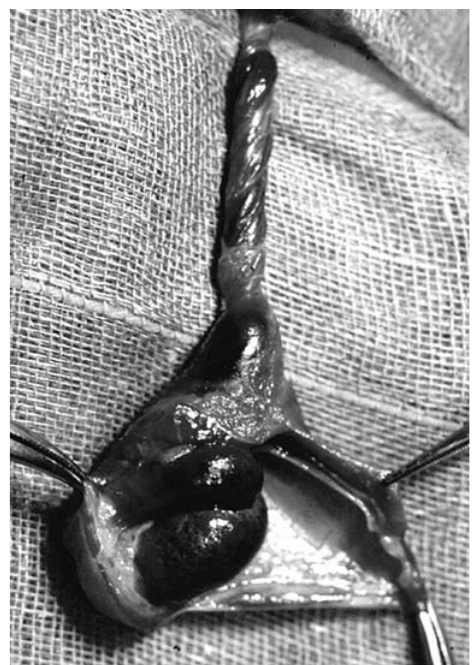
Figure 3 – Twists of spermatic cord in case of extravaginal torsion (EVT) are located much more proximal compared with intravaginal testicular torsion. Moreover, in contrast with bell clapper deformity appearing in cases of intra- vaginal torsion, in EVT testicular attachments with tunica vaginalis appear to be present.